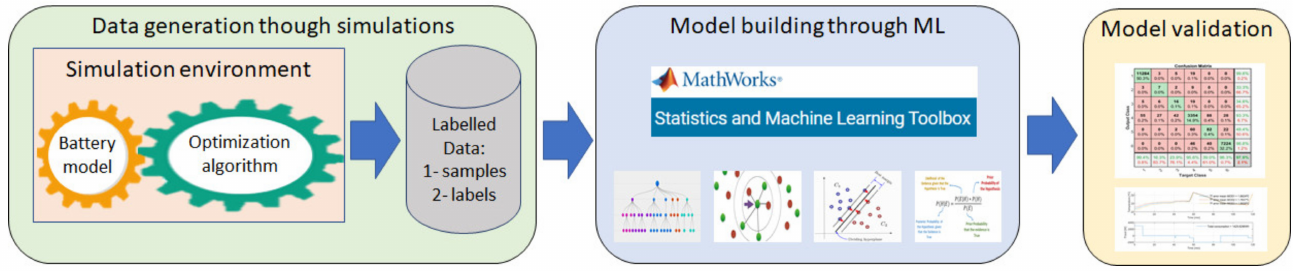
Figure 4. Methodology to build the proposed surrogate control